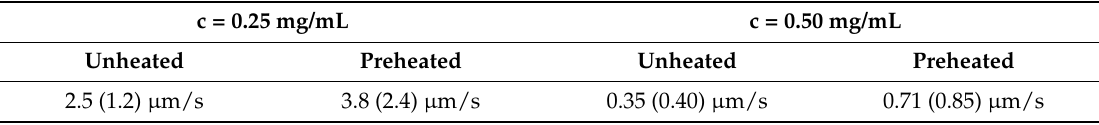
Q = 20 μ L/min. The values in the brackets show the standard deviation.